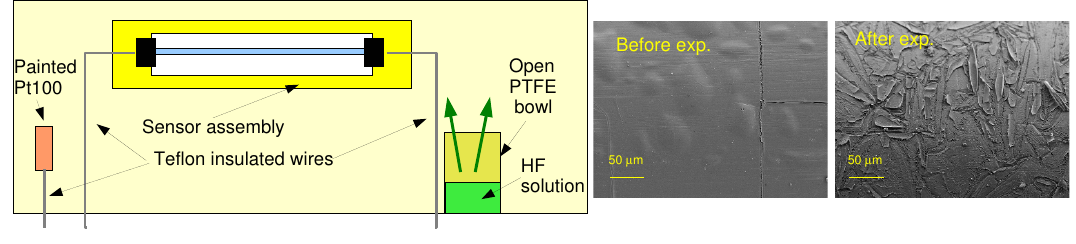
Figure 9. ( Left ) Setup used for sensor characterization; ( Right ) FESEM images of the fiber surface aspect before and after exposure to the HF